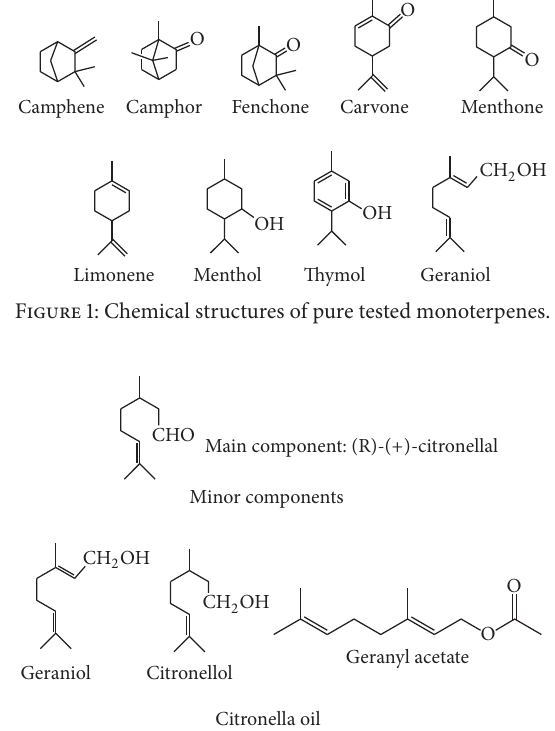
Figure 2: Constituents of citronella oil (R-(+)-citronellal as a main component and geraniol, citronellol, and geranyl acetate as minor